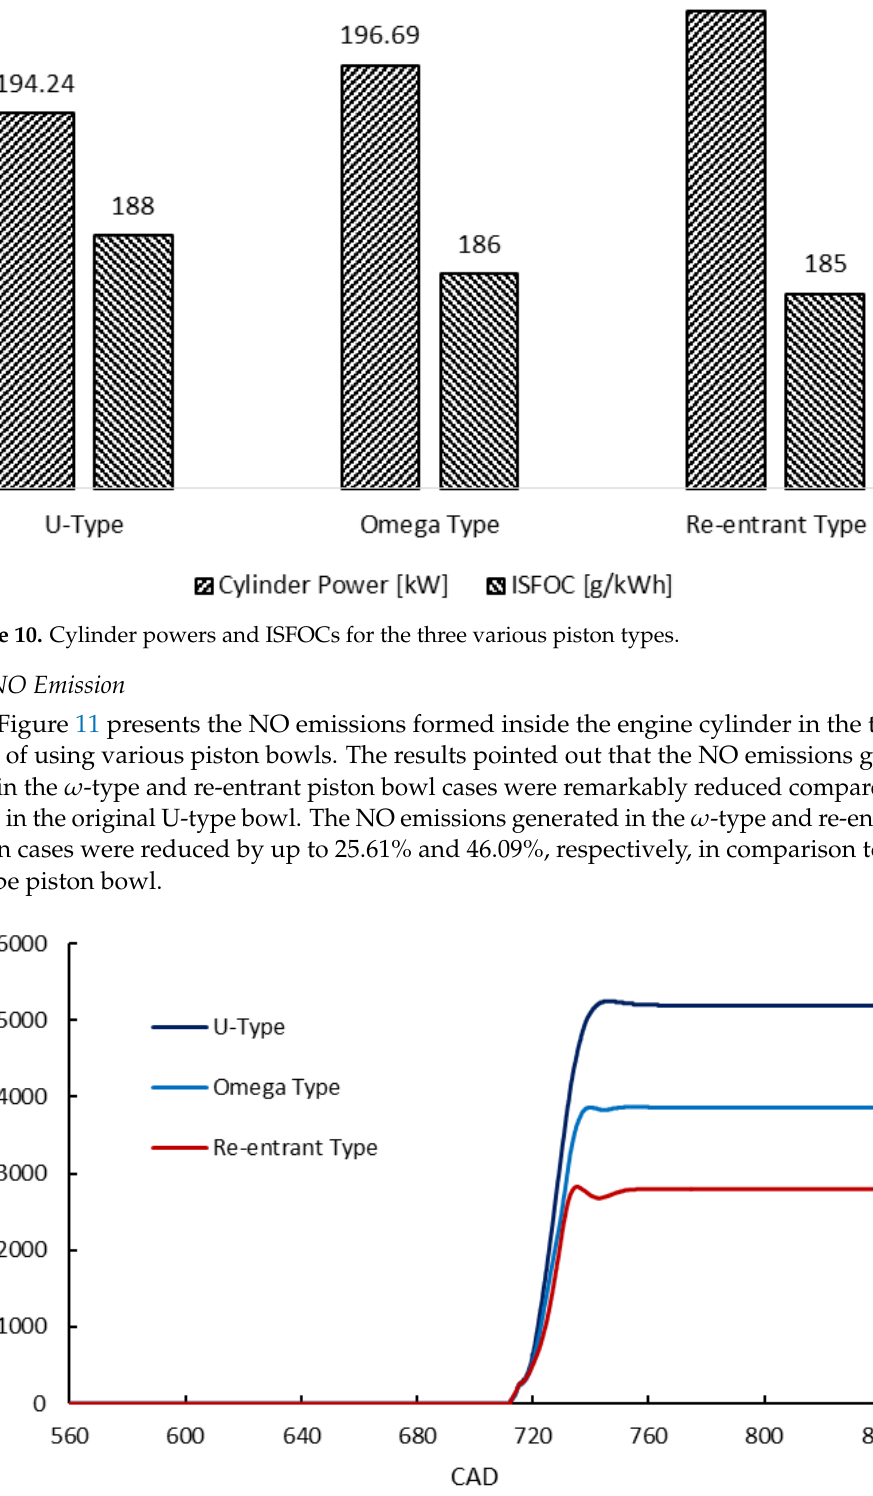
Figure 11. NO emissions diagrams for the three various piston types.